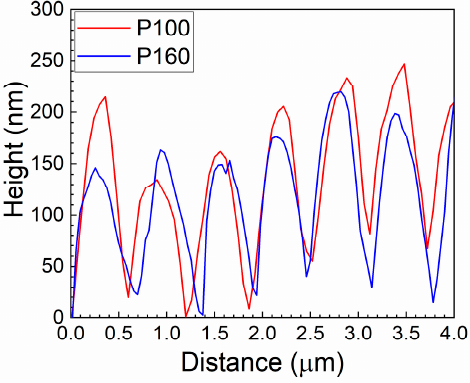
Figure 6. AFM images of sample P100: ( a ) map of 15 × 30 μ m 2 ; ( b ) map of 5 × 5 μ m 2 (shown in both top-view and tilted-view representation), and sample P160: ( c ) map of 15 × 30 μ m 2 and ( d ) map of 5 × 5 μ m 2 (shown in both top-view and tilted-view representation).